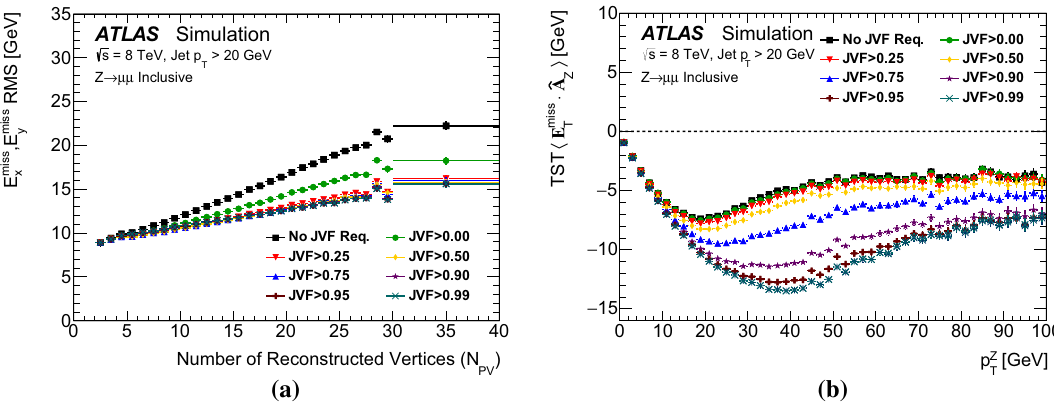
Fig. 18 The a TST E miss resolution versus the number of reconstructed vertices per bunch crossing ( N PV ) and the b TST (cid:3) E miss T are shown for the different JVF selection criterion values applied to jets with p T > 20 GeV and | η | < 2.4 using the Z → μμ of the (cid:3) p Z T